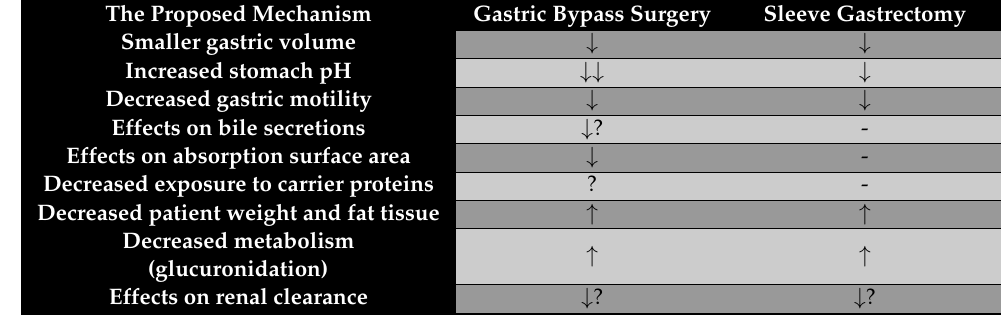
Table 1. Summary of mechanisms involved in increased ( ↑ ) or decreased ( ↓ ) lamotrigine levels after gastric bypass or sleeve gastrectomy surgeries. (?) is added if mechanism effects are suspected or